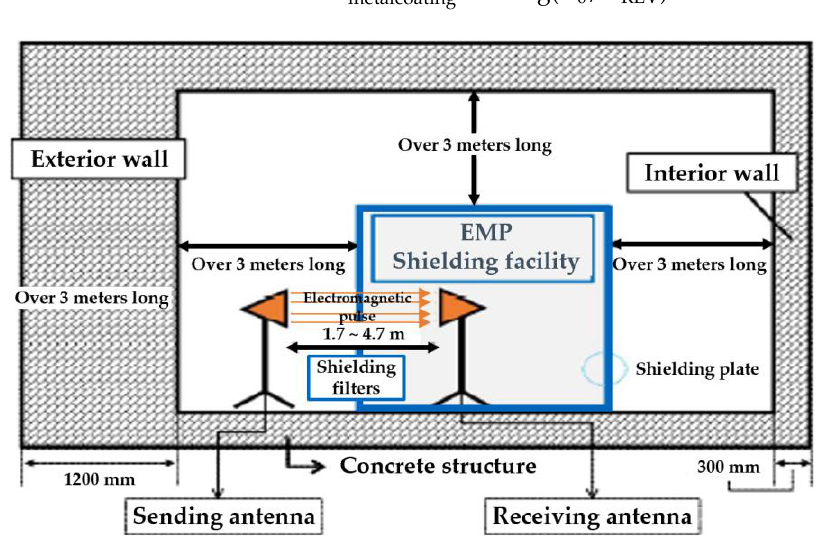
Figure 4. Concrete specimen shielding effect test.